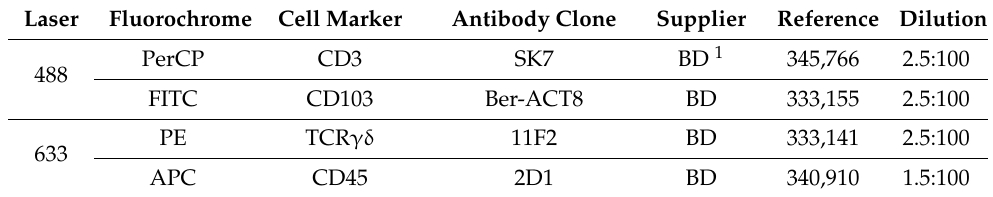
Table 1. Antibodies used for flow cytometry